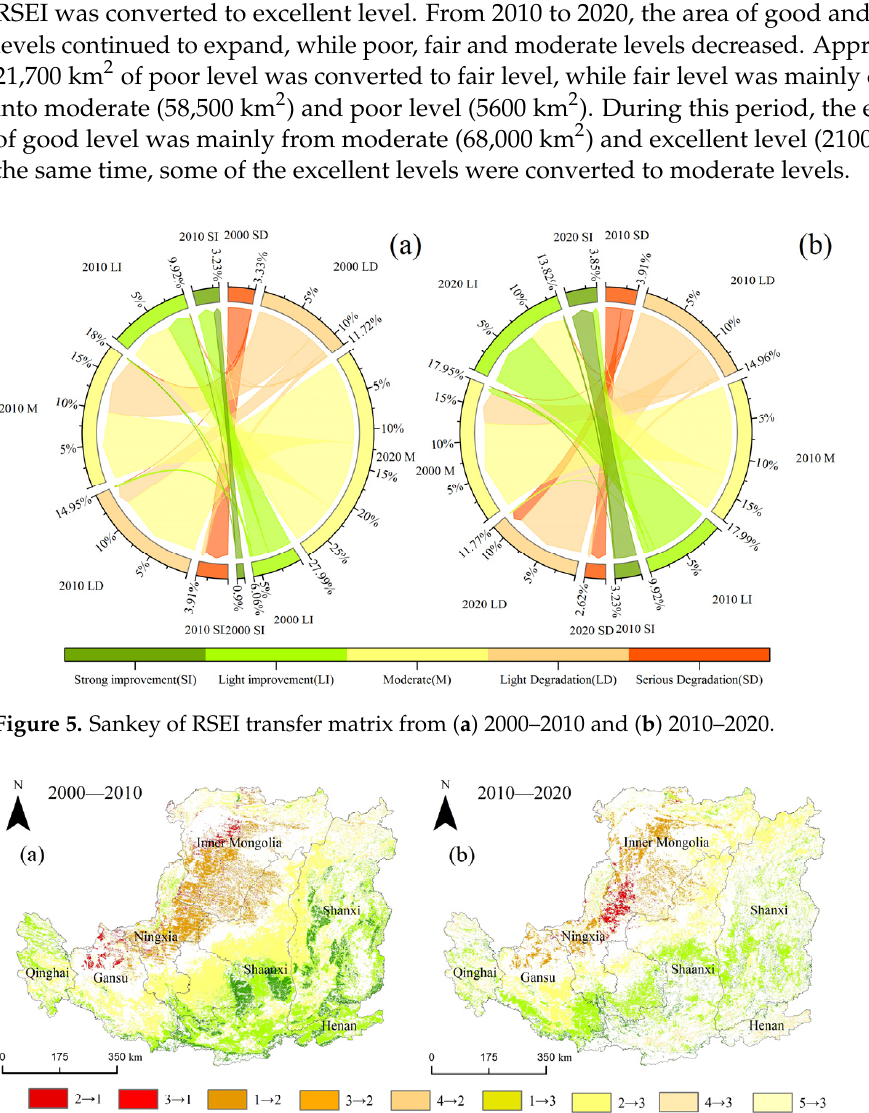
1: poor, 2: fair; 3: moderate; 4: good; 5: